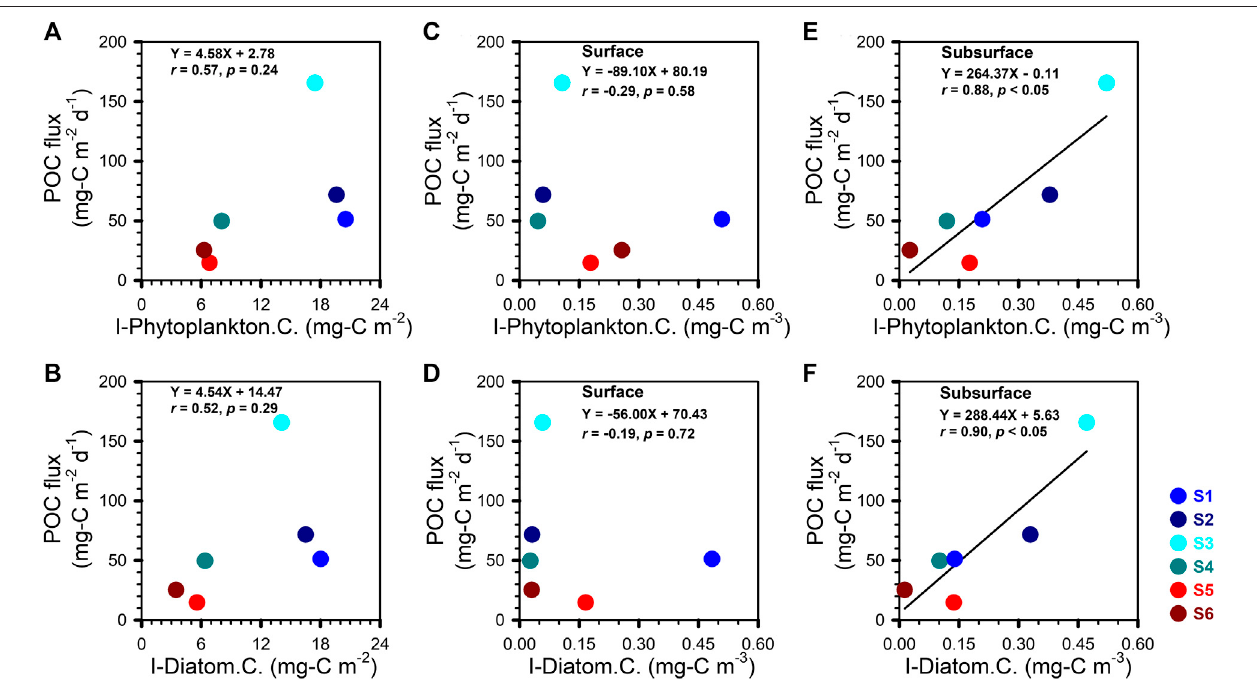
FIGURE6| POC fl uxesvs. (A , B) I-Phytoplanktonand I-Diatom carbon inventories (I-Phytoplankton C .and I-Diatom C .); (C , D) phytoplanktonand diatom carbon contents (Phytoplankton C. and Diatom C.) in surface waters; (E , F) phytoplankton and diatom carbon contents (Phytoplankton C. and Diatom C.) in subsurface waters (i.e., SCM). The lines in the E and F denoted the result of linear regression.